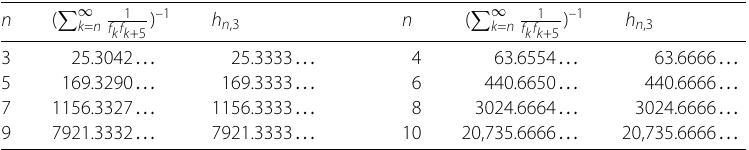
(cid:9) ∞ 1 ) k = n f k f k +5